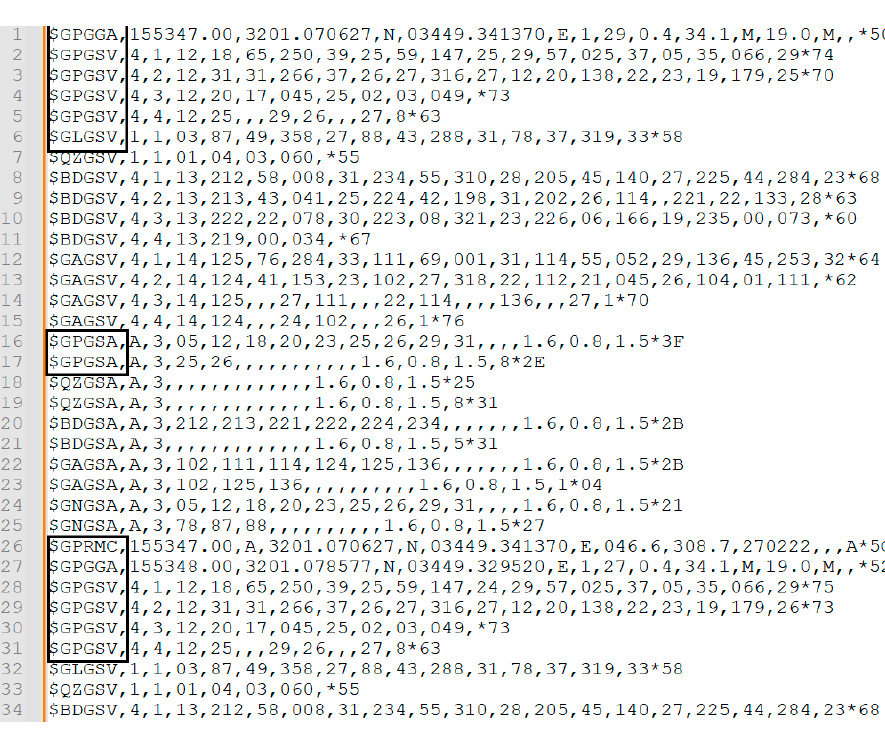
Figure A1. Untouched file from NMEA Logger before filtering.